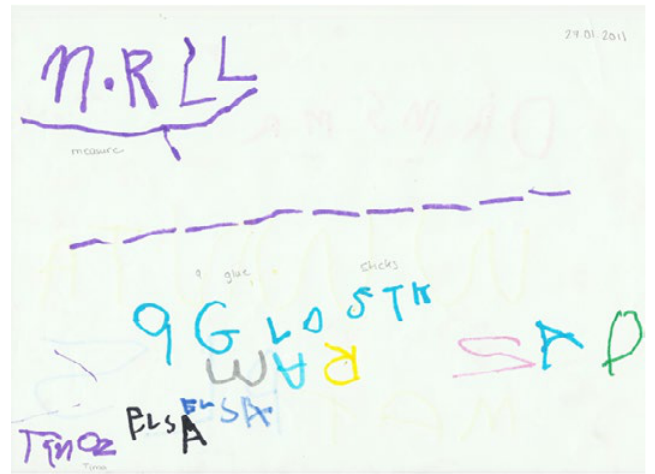
Figure 1: Letter from a group of four-year-old children requesting a new classroom doormat that is nine glue sticks in